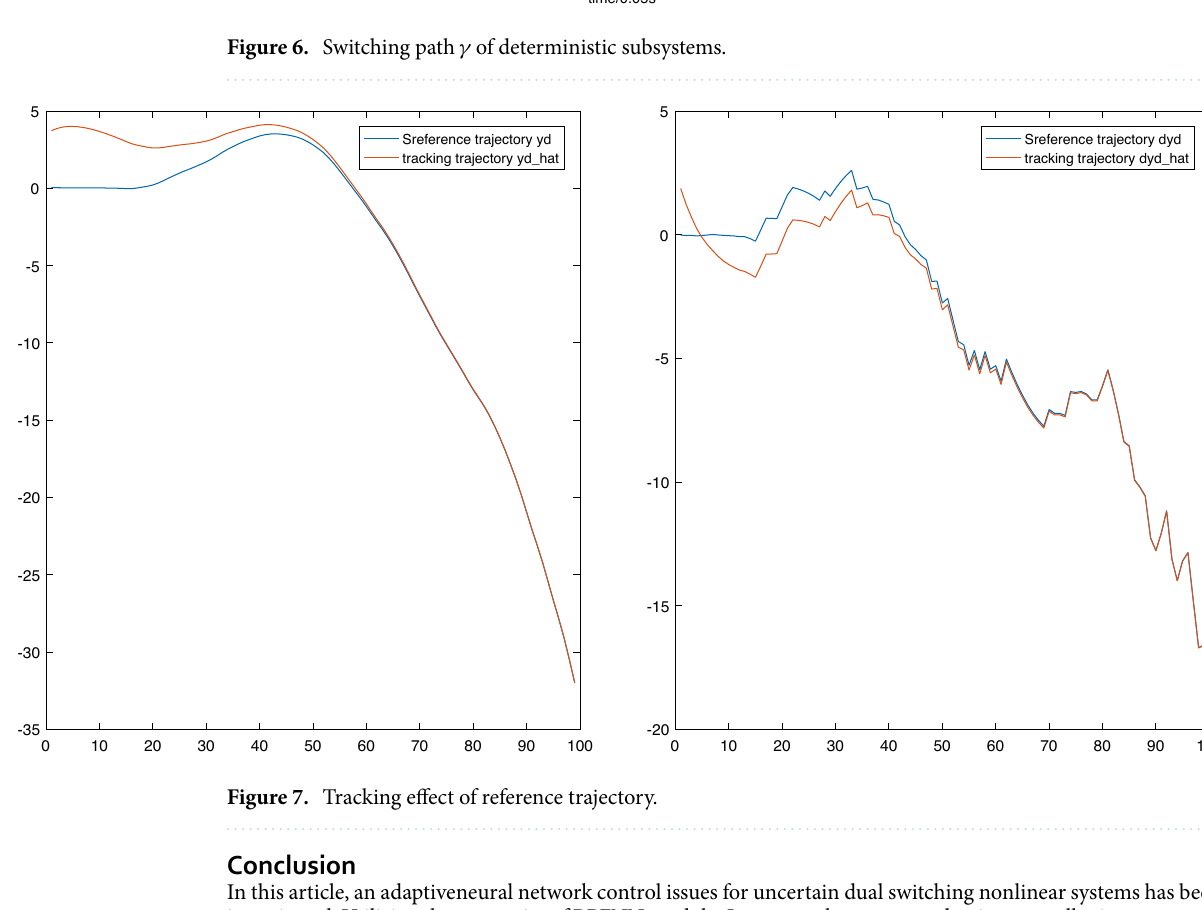
Figure 6. Switching path γ of deterministic subsystems.